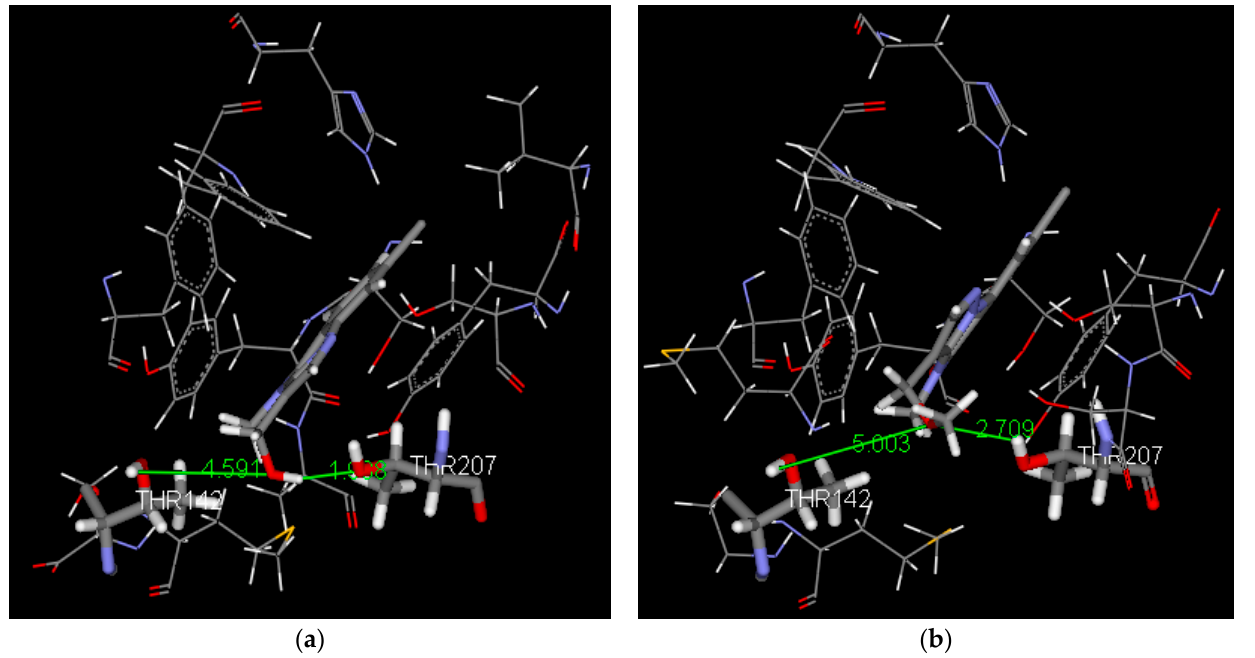
Figure 3. Hydrogen bond interaction of compound 18 ( a ) and of compound 19 ( b ) in the last frame of the dynamic simulation.